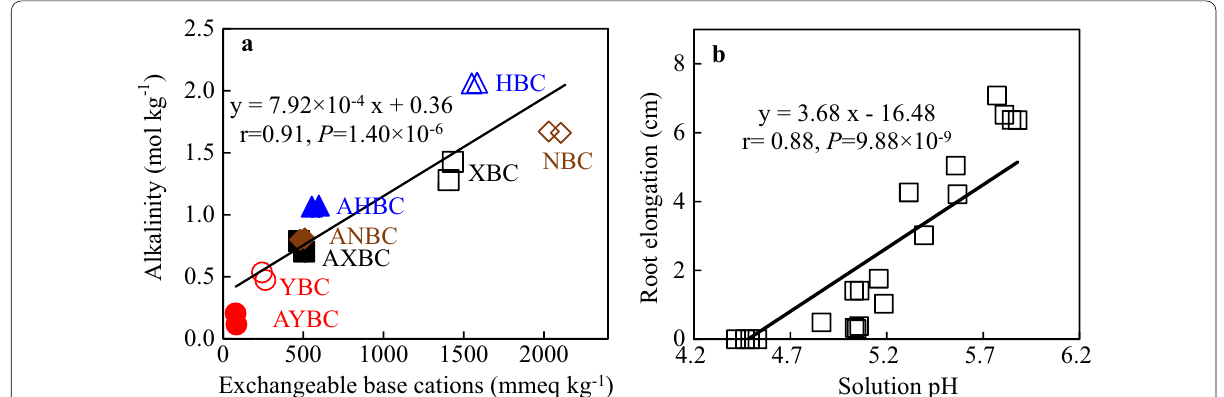
Fig. 1 Relationships between biochar exchangeable base cations and alkalinity ( A ), reaction solution pH amended with different doses of Ca(OH) 2 and root elongation of wheat seedlings after 48 h exposure to 50 μmol L. − 1 Al(III) solution ( B